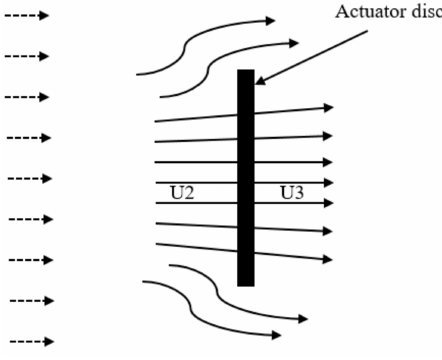
Figure 3. Flow di ff usion due to the shadowing e ff ect of the actuated